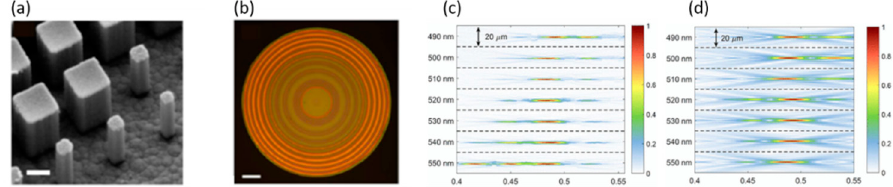
Figure 5. A 60 nm bandwidth achromatic metalens. ( a ) Side view scanning electron microscope (SEM) image of the fabricated AML, scale bar: 200 nm. ( b ) Optical image of the AML. Scale bar: 25 μ m. ( c ) Measured intensity profiles of the reflected beam by the AML in the 𝑥𝑧 -plane at different wavelengths. ( d ) Simulated intensity profiles of the reflected beam by the AML in the 𝑥𝑧 -plane at different wavelengths. (Reproduced from [32] with permission.)